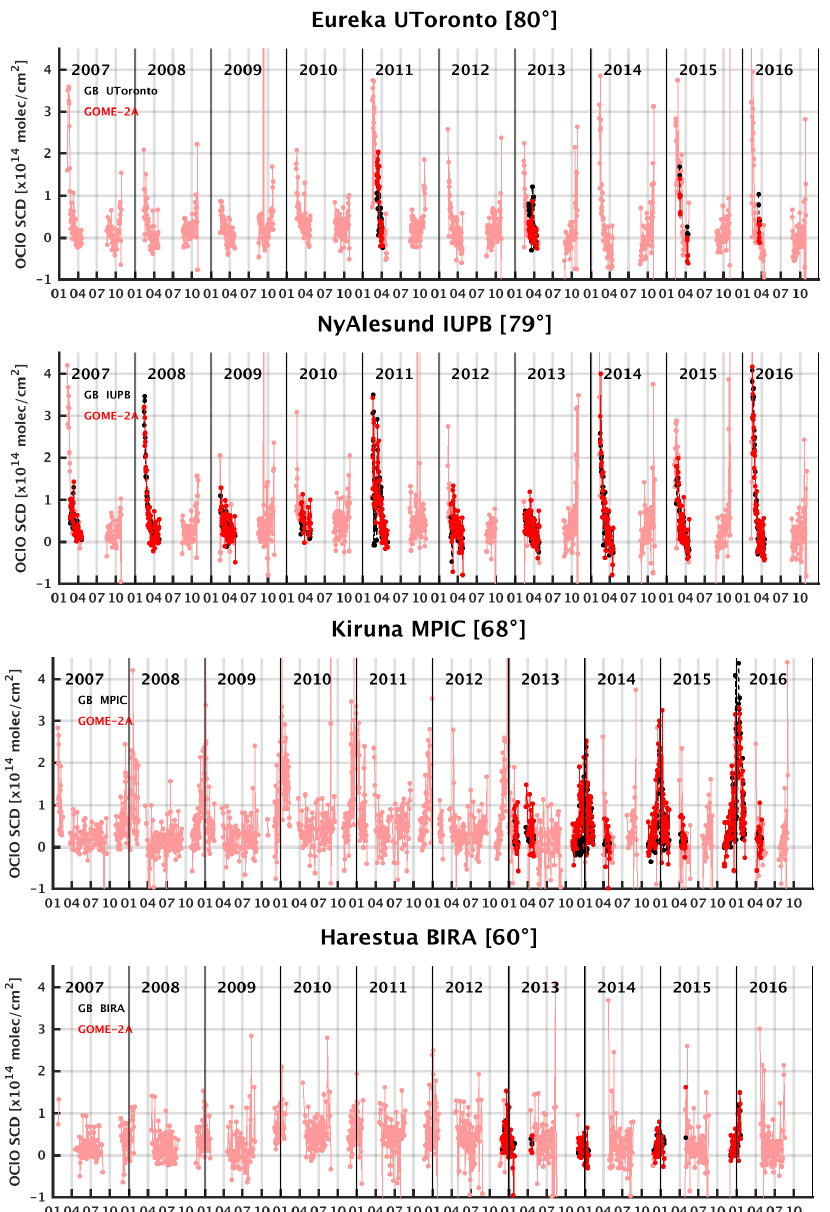
Figure 13. Time series of GOME-2A (red) OClO daily mean slant column data co-located with ground-based (black) measurements per- formed at each Arctic station. The lighter transparent red color is used for GOME-2A when there are no ground-based measurements.